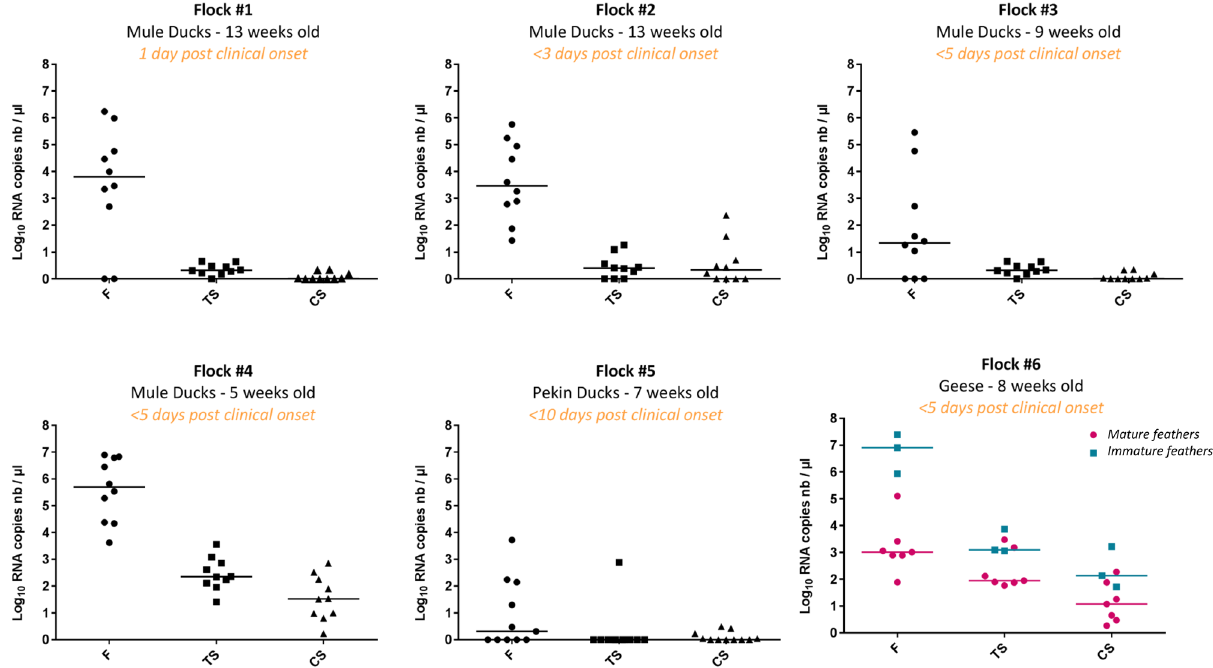
Figure 2. Viral RNA loads in feathers (F), tracheal swabs (TS) and cloacal swabs (CS) in 6 naturally infected flocks with H5N8 HPAIV. Mule ducks (4 flocks, n = 10 birds per flock), pekin ducks (1 flock, n = 11) and geese (1 flock, n = 10). Results are expressed as log 10 viral RNA copies/µL.